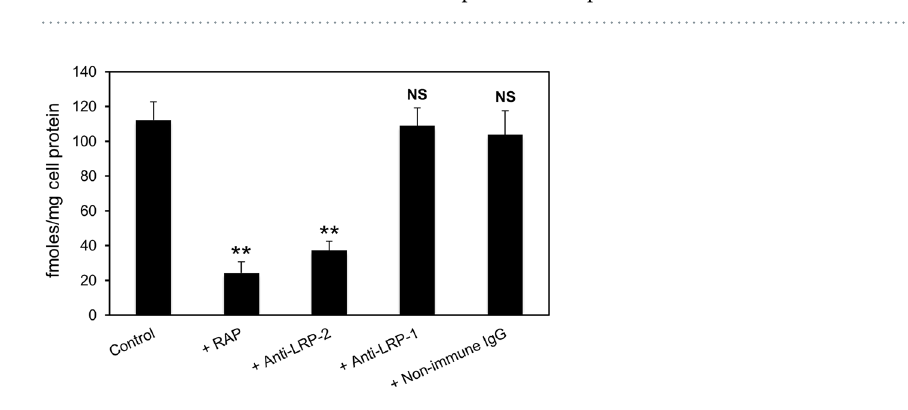
Figure 2. Time-course of cell-surface binding of 125 I-proMMP-2:TIMP-2 complex. BN16 cells were incubated with 10 nM 125 I-proMMP-2:TIMP-2 complex at 4 °C for the indicated intervals to allow surface binding, in the absence (open circles) or presence of 1 μ M RAP (closed circles), then washed and treated with pronase ® for detachment. Surface-bound 125 I-proMMP-2:TIMP-2 complex was defined as pronase ® -sensitive radioactivity. Values are means ± S.D. of three dishes. This experiment was performed twice with similar results.